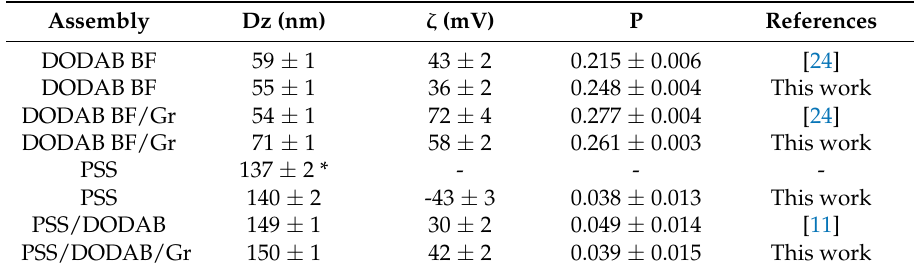
Table 1. Physical characterization of DODAB BF, DODAB BF/Gr, PSS, PSS/DODAB, and PSS/DODAB/Gr assemblies in 1 mM NaCl aqueous solution.